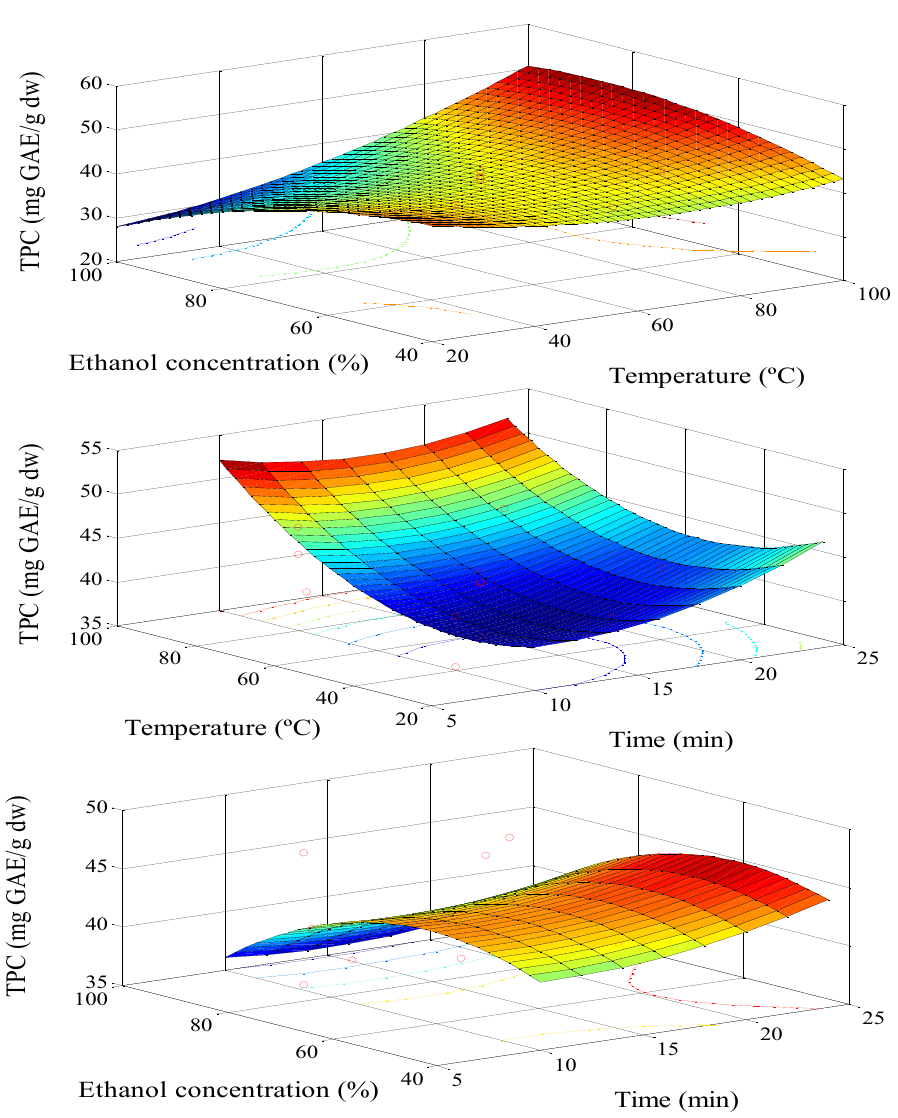
Figure 1. Response surface model plot: the variable is the total phenolic content (TPC) of the extract. % EtOH with temperature; temperature with time; % EtOH with